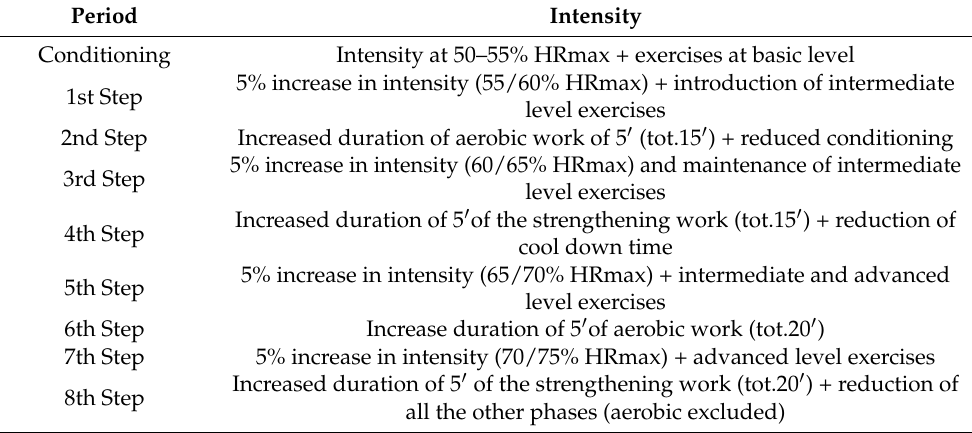
Table 1. Training protocol with progressive changes in duration and